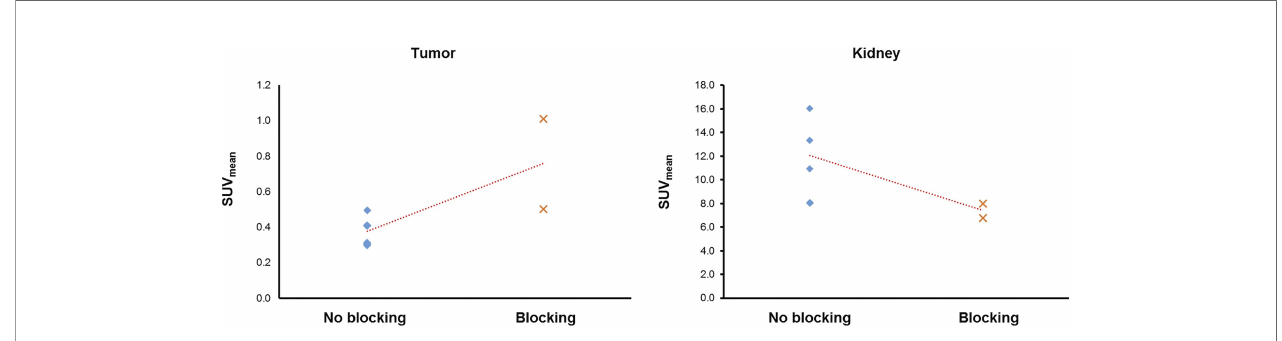
FIGURE 6 | Tumor (left) and kidney (right) 18 F-PSMA-1007 uptake in blocked and unblocked mice. Blocked mice received a bolus injection of cold PSMA reference standard prior to PET imaging with hot 18 F-PSMA-1007. Surprisingly, the SUV mean was lower in unblocked mice than in blocked mice. Kidney uptake decreased in blocked mice and con fi rms successful blocking (right).